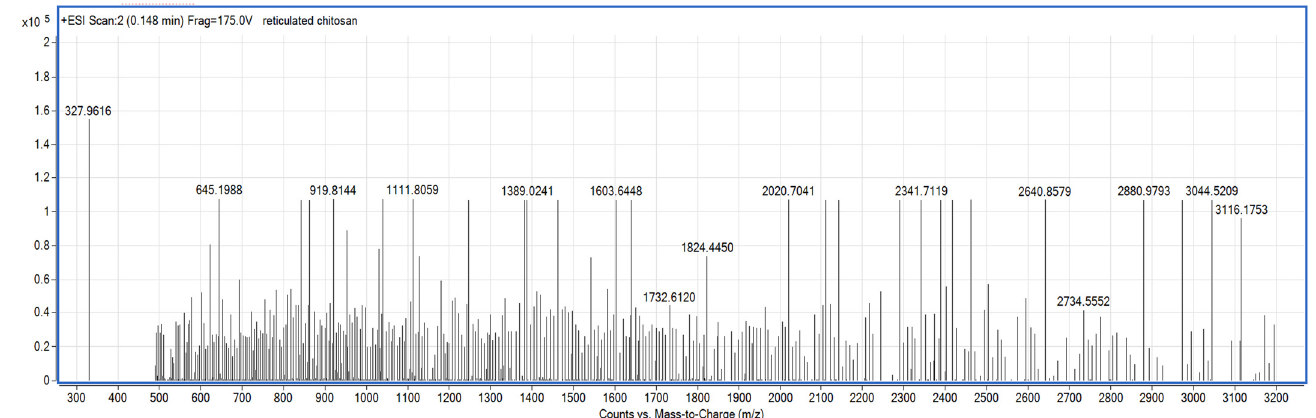
Figure 3. Analysis of chitosan solution reticulated with acetic acid after 24 h of maturation.